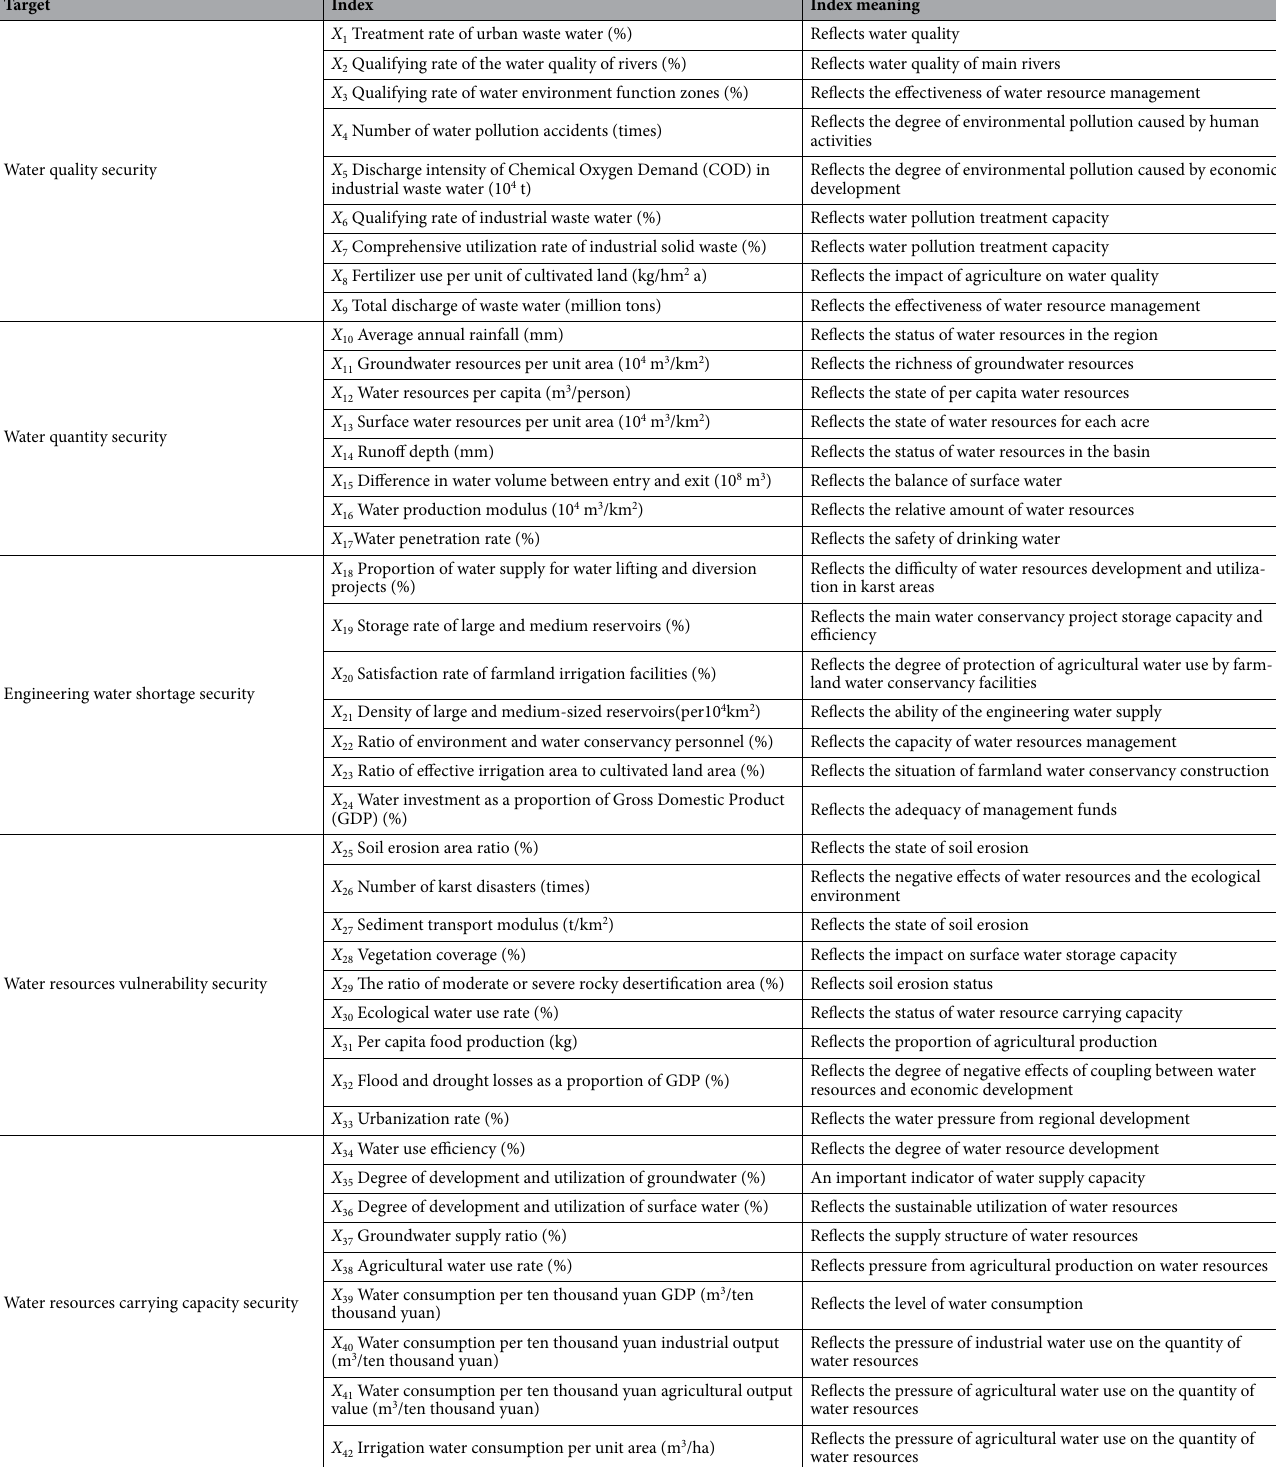
Table 1. Primary evaluation index system for water resource security in the karst